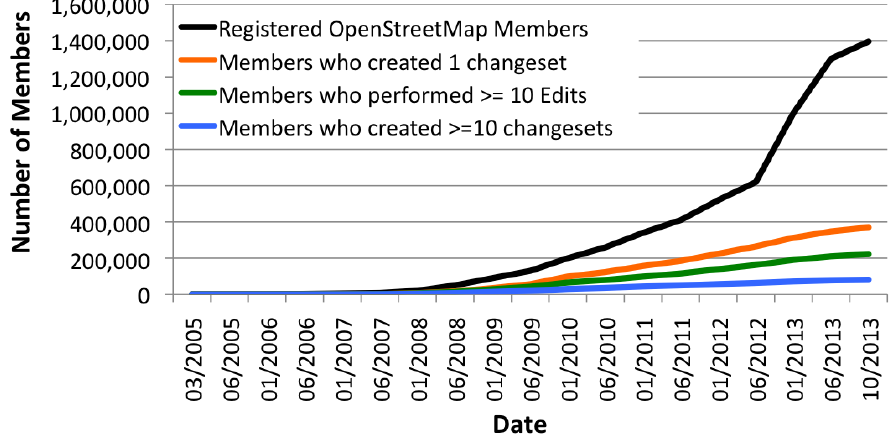
Figure 2. Growth of OpenStreetMap membership numbers between 2005 and 2013.